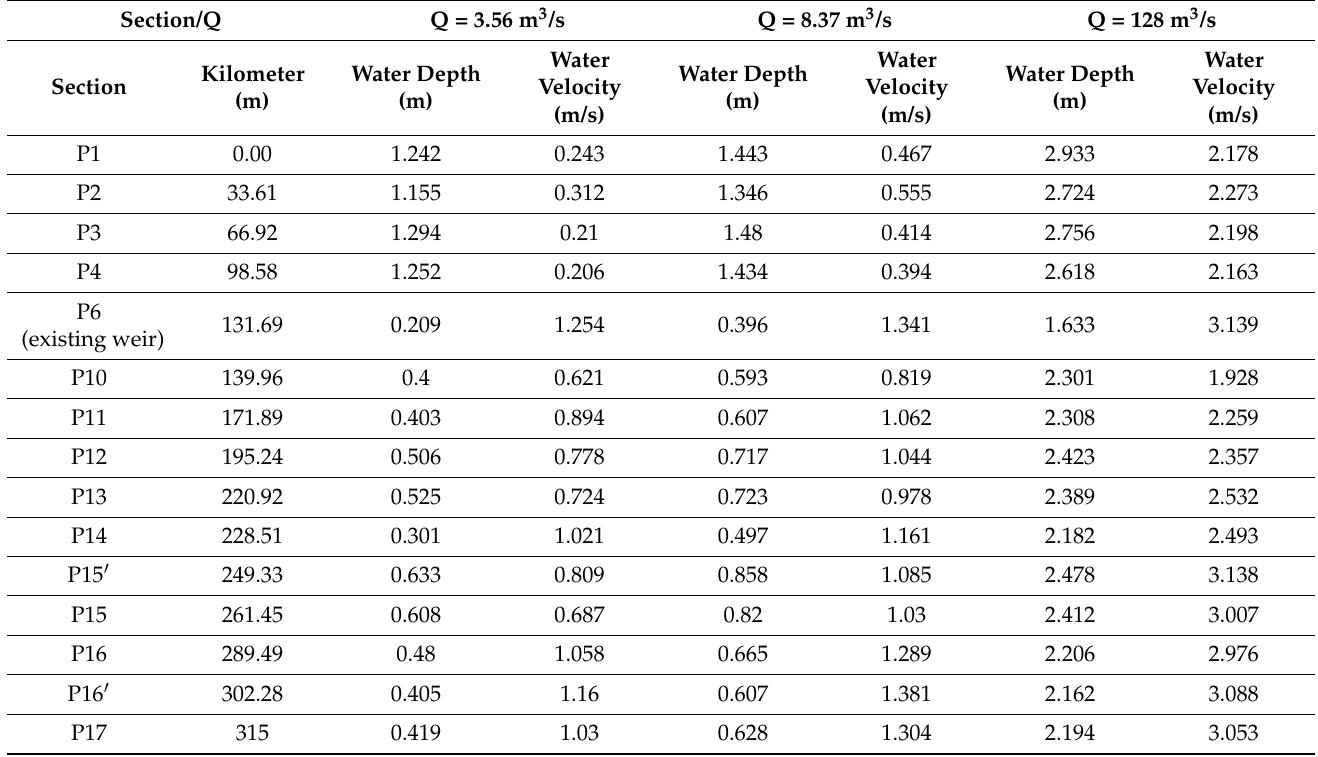
Table 2. The depth and velocity of the water in each cross-section for all simulated flows. For the case where there is only one weir, the existing one.